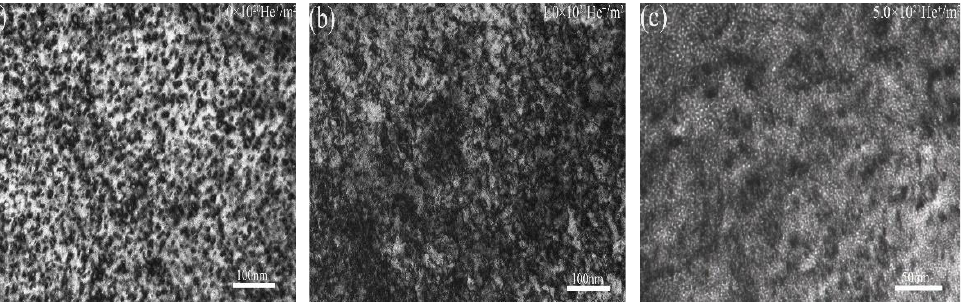
Figure 6. TEM images showing the microstructural evolution in pure W exposed to 5 keV He + as a function of fluence: ( a ) 1.0 × 10 20 He + /m 2 ; ( b ) 1.0 × 10 21 He + /m 2 ; ( c ) 5.0 × 10 21 He + /m 2 .